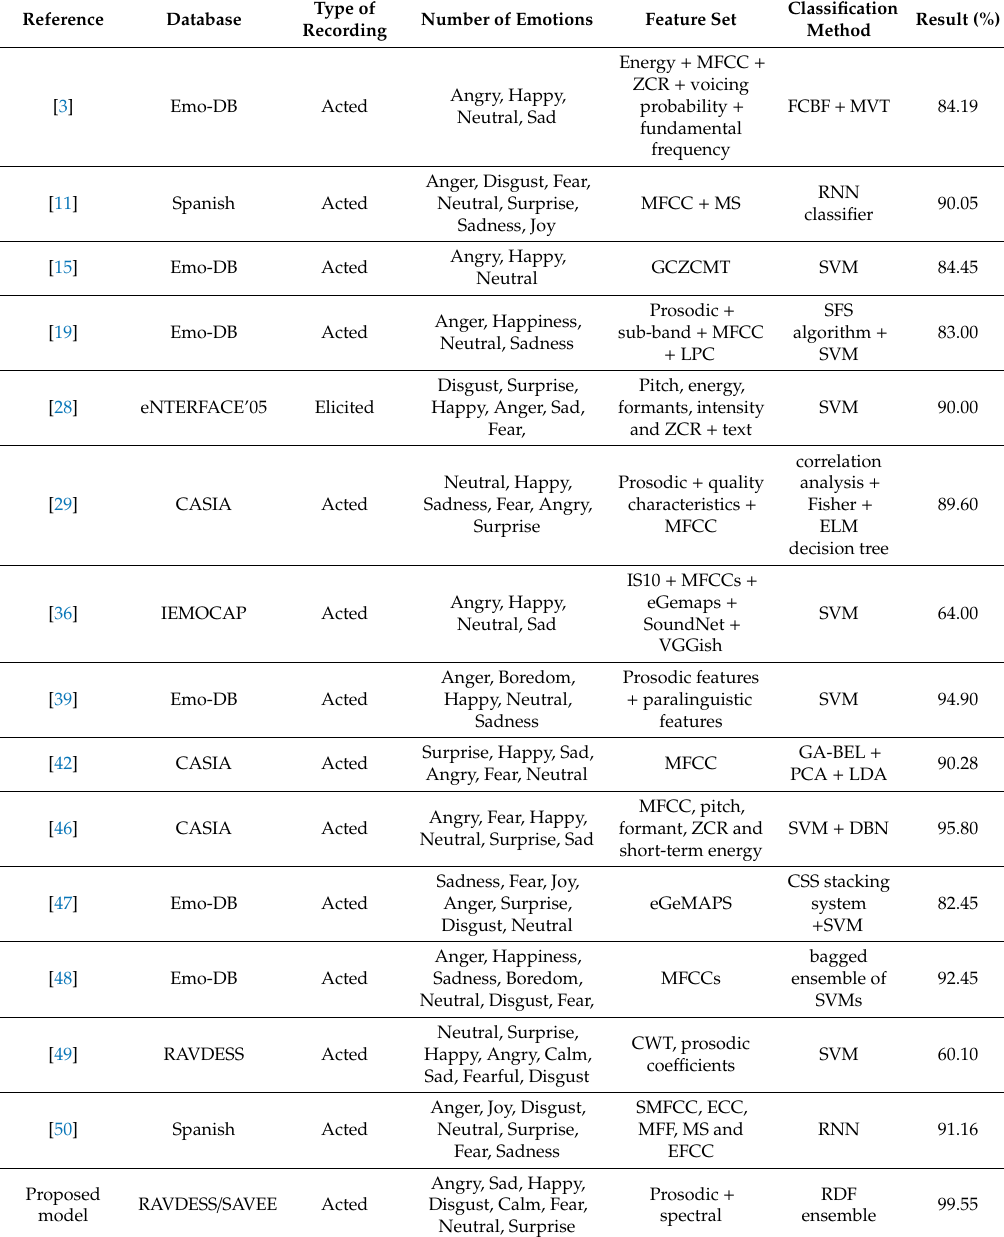
Table 1. A comparison of our method with related